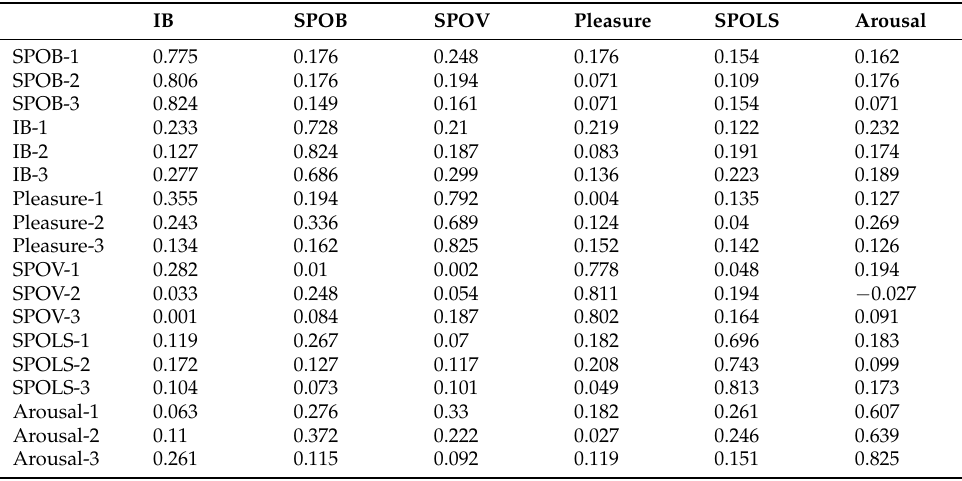
Table A1. Item loadings and